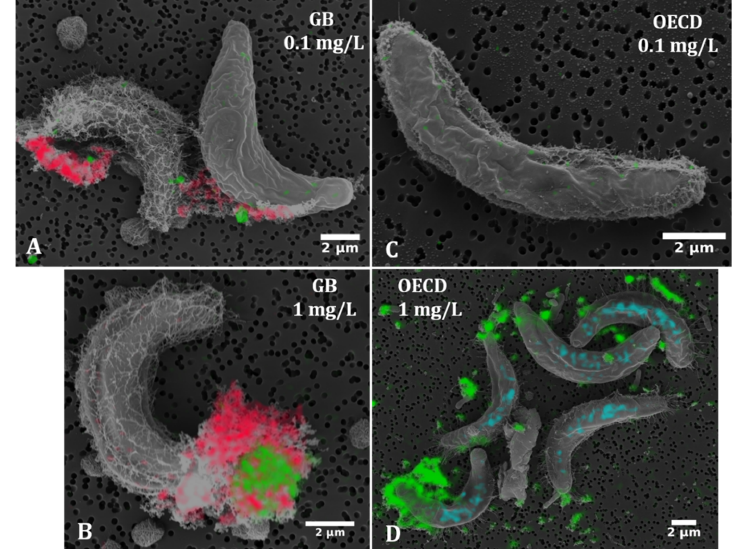
Figure 5. SEM-EDX (energy-dispersive X-ray spectroscopy) images of Raphidocelis subcapitata cells following exposure to CeO 2 NM-212 at two concentrations in two media, GB ( A , B ) and OECD ( C , D ). Some cells appear to be covered by network-like structures (potentially extracellular polymeric substances or artifacts that appear during sample preparation). Optically identical particulate assemblies are associated with the cells and, based on EDX analysis, contain not only cerium (green), but also sodium (blue) and iron (red). The coverage of algal cells with NM-212 particles was quantified from the overlay of SEM and EDX images. This showed no significant difference between the GB and OECD media at an ENM concentration of 0.1 mg/L (2–3% coverage in each case), but a trend towards higher coverage in OECD medium (14% in OECD vs. 2.4% in GB) at an ENM concentration of 1 mg/L (Figure 6).